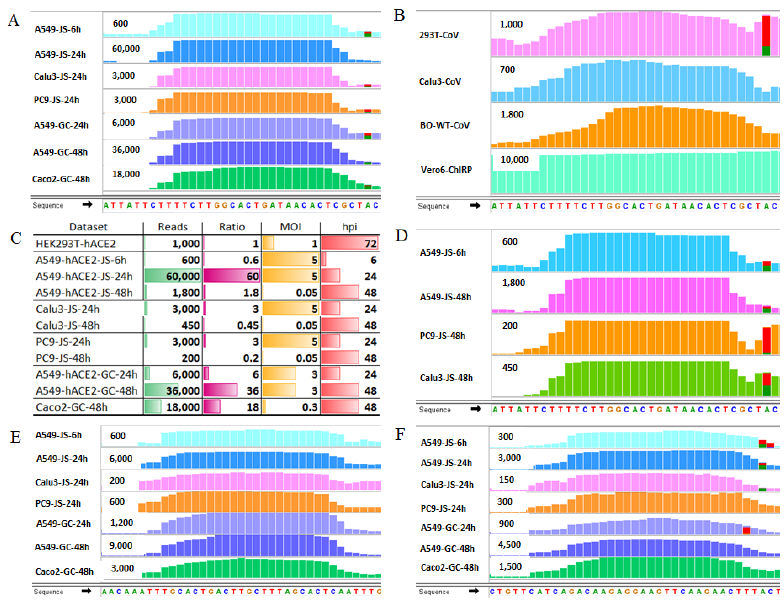
Figure 5. Plots and IGV view of vmiR-ORF7a reads distribution. ( A ) Read distribution of vmiR- ORF7a in datasets of GC and JS. ( B ) Read distribution of vmiR-ORF7a in datasets of HEK293T-hACE2, Calu3-EW, and BO-WT-CoV. ( C ) IGV estimated reads of vmiR-ORF7a in HEK293T-hACE2, datasets of GC and JS. ( D ) Reads distribution in datasets of JS at 6 hpi (MOI = 5) versus at 48 hpi (MOI = 0.05). Column “Ratio” refer to ratio of IGV estimated read count in datasets of GC and JS to read count in dataset of HEK293T-hACE2. ( E ) Read distribution of vmiR-ORF7a-2 in datasets of GC and JS. ( F ) Read distribution of vmiR-ORF7a-3 in datasets of GC and JS. Refer to Table 1 for detailed information of infection and the abbreviations of the